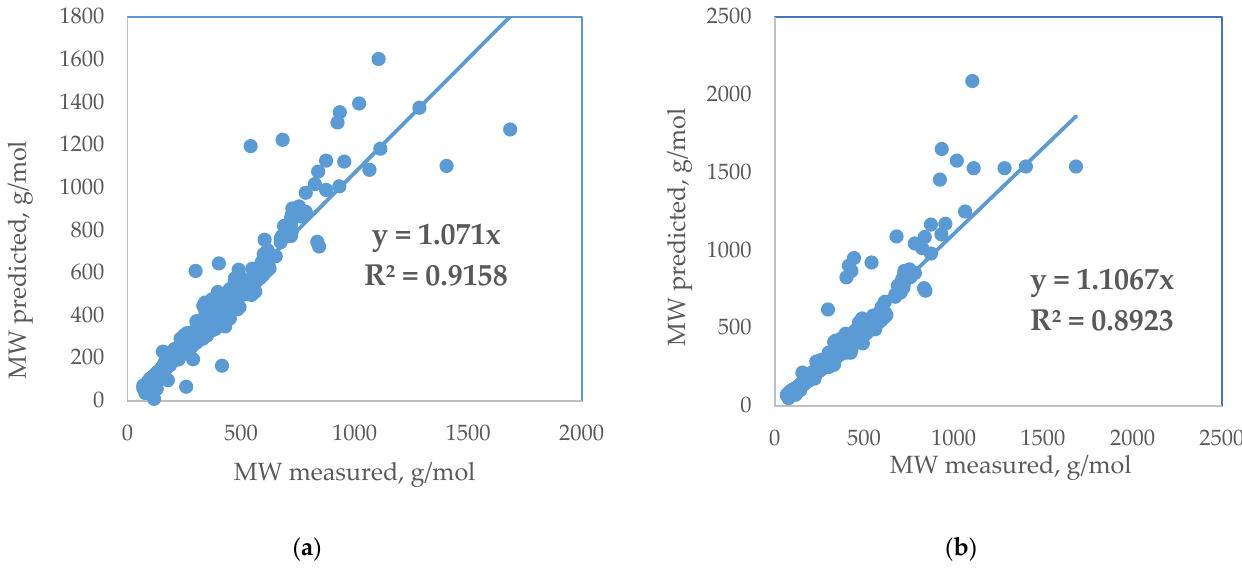
Figure 11. Parity graph for predicted versus measured molecular weight by Equation (6) (Soreide) ( a ) and by Equation (12) (Lemus et al.) ( b ). Table 4. Statistical analysis of the new empirical correlation developed in this work, and of the cor ‐ relations of Goosens, Riazi and Daubert, and API with 124 data points not used in their develop ‐ ment.